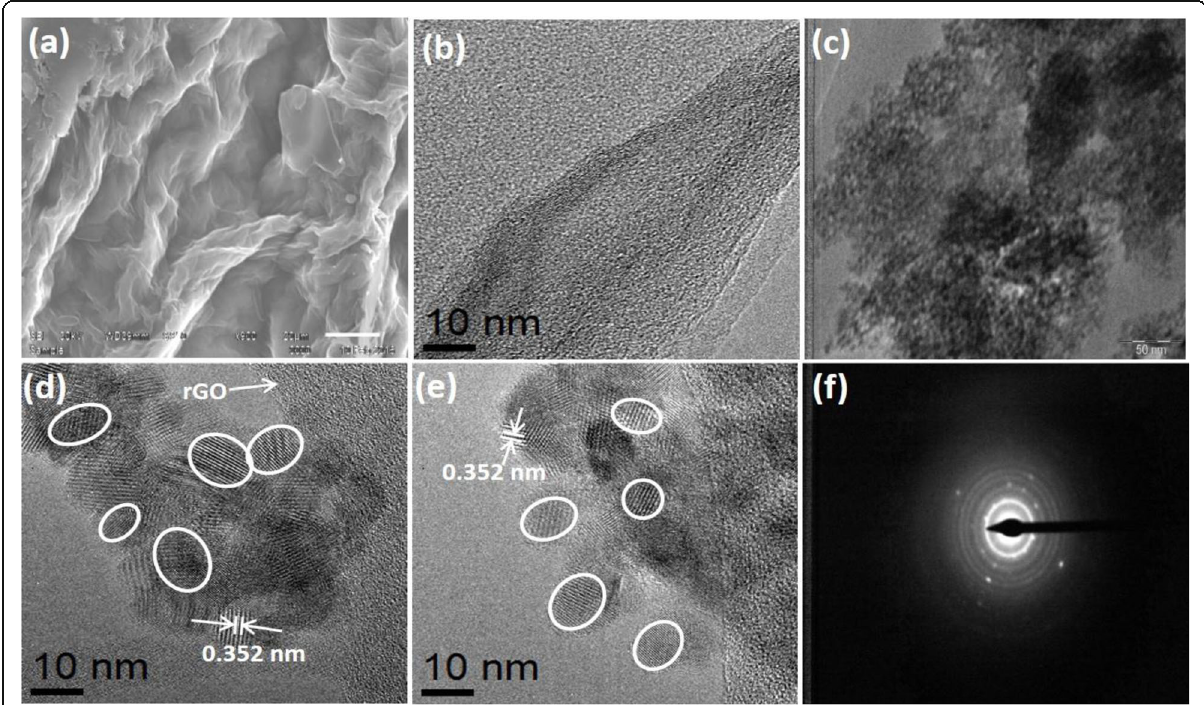
Fig. 4 (a) SEM image of GO, (b) HRTEM images of GO, (c) TEM image of NTG5, (d) and (e) are HR-TEM images of NTG5, (f) SAED patterns of